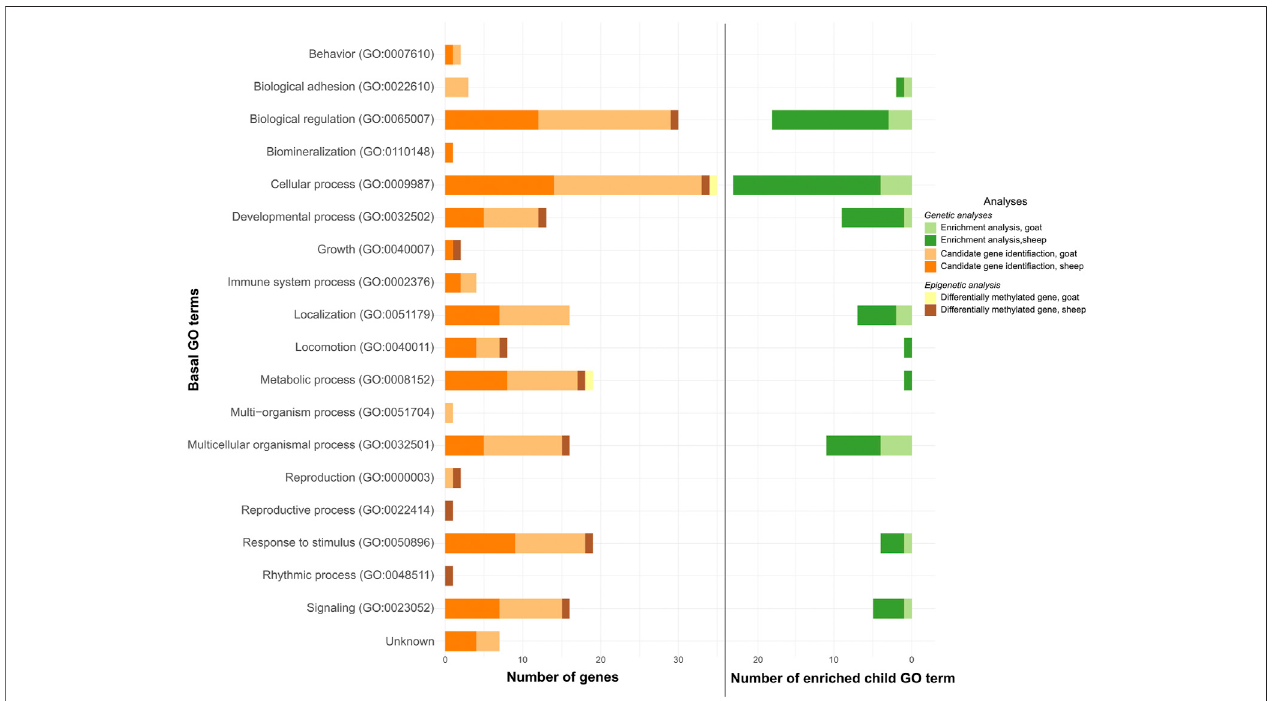
FIGURE 2 | GO terms putatively involved in the adaptation and acclimation of small ruminants to temperature variations. Number of genes or child GO terms per basalGO terms for candidate gene identi fi cation (under selection -oranges-and differentially methylated -yellow/brown-) and enrichmentanalysis (greens), respectively.